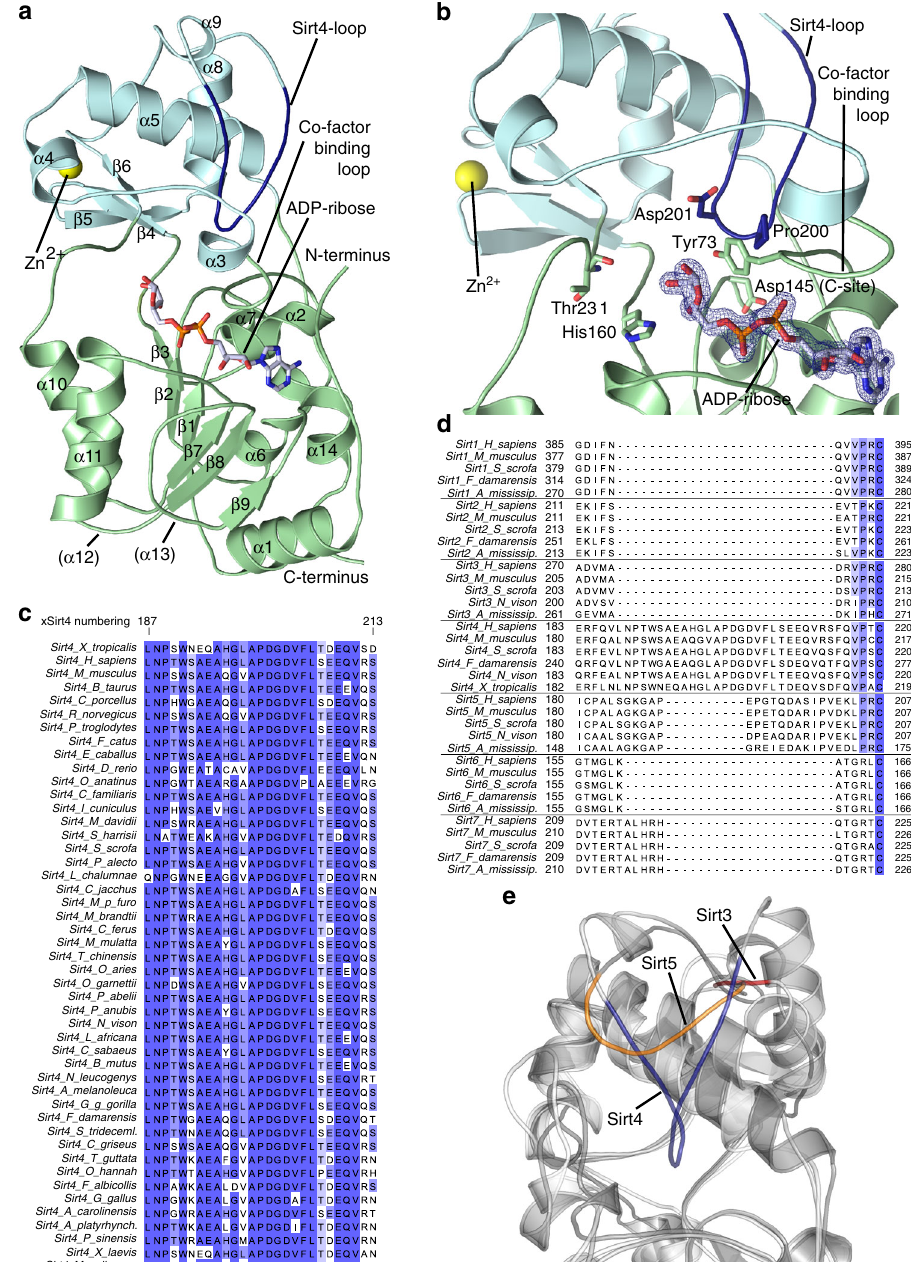
Fig. 2 Crystal structure of xSirt4. a Overall structure of the xSirt4/ADPr complex, with Rossmann-fold domain (green), Zn 2+ -binding domain (cyan), and a Sirt4-speci fi c loop (blue) indicated. ADPr is shown as sticks, colored according to atom type. Secondary structure elements are numbered equivalent to other sirtuins, elements missing in xSirt4 are indicated by brackets. b xSirt4 active site, with conserved sirtuin catalytic residues and key residues of the Sirt4-loop shown as sticks. ADPr sticks are colored according to atom type and overlaid with 2F o – F c electron density (1 σ ). c Alignment of the Sirt4-loop region in Sirt4 sequences from various chordates (Full alignment: Supplementary Fig. 2c). d Section of a structure-based alignment of Sirt1 – 6, extended by chordate Sirt1 – 7 sequences, showing the isoform differences in the Sirt4-loop region (Full alignment: Supplementary Fig. 2d). e Overlay of xSirt4 (gray, blue) with Sirt3 (light gray, red; PDB ID 4BVH) and 5 (dark gray, orange; 4G1C) showing the extended Sirt4-loop, the shorter Sirt5 surface loop, and the short turn in Sirt1 – 3 (represented by